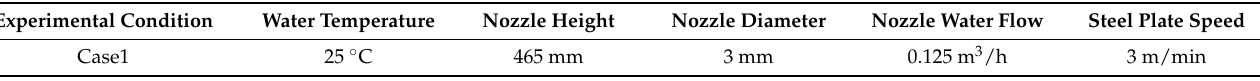
Figure 2. Steel plate hole location map. Table 2. Experimental conditions at 1 mm from the hole to the upper